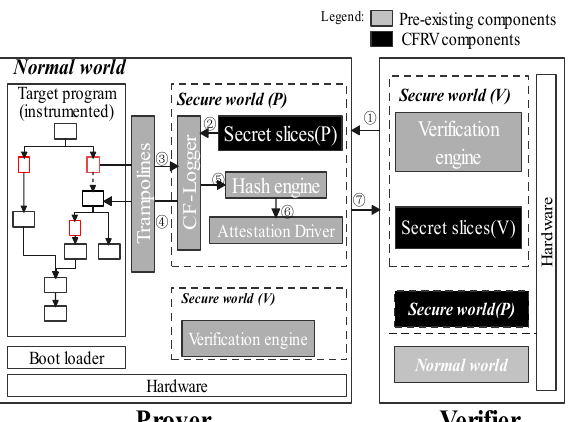
Figure 4. The remote verification architecture.